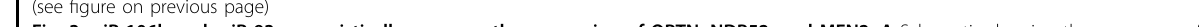
Fig. 3 miR-106b and miR-93 synergistically suppress the expression of OPTN, NDP52, and MFN2. A Schematic showing the sequences of human miR-106b and miR-93, which were predicted to target the 3 ’ UTRs of OPTN, NDP52, and MFN2. B Schematics representing the reconstructed dual-luciferase reporter plasmids. The WT 3 ’ UTRs of OPTN, NDP52, and MFN2 containing the miRNA-binding sequences were cloned downstream of Renilla luciferase ( hRluc ). Arti fi cially mutated miRNA-binding sequences (OPTN-Mut, MFN2-Mut, and NDP52-Mut) were also cloned downstream of Renilla luciferase. Mutations are marked in red. C Cells were transfected with reporter plasmids containing the WT 3 ’ UTR of OPTN or a mutant OPTN 3 ’ UTR (OPTN-Mut) along with a miR-106b mimic or miR-93 mimic for 48 h. Fire fl y luciferase ( hluc + ) and Renilla luciferase ( hRluc ) activity levels were measured successively, and the values are presented as the relative fl uorescence intensity ( hRluc/hluc + ). N = 3; ** P < 0.01. The quanti fi ed results are presented as the mean ± SD. D Cells were transfected with reporter plasmids containing the WT 3 ’ UTR of MFN2 or a mutant MFN2 3 ’ UTR (MFN2-Mut) along with a miR-106b mimic or miR-93 mimic for 48 h. The Renilla luciferase activity was normalized to the fi re fl y luciferase activity. N = 3; ***P < 0.005; **** P < 0.001. The quanti fi ed results are presented as the mean ± SD. E Cells were transfected with reporter plasmids containing the WT 3 ’ UTR of NDP52 or a mutant NDP52 3 ’ UTR (NDP52-Mut) along with a miR-106b mimic or miR-93 mimic for 48 h. The normalized luciferase activity (ratio of hRluc to hluc + ) was measured in cell lysates. N = 3; *** P < 0.005. The quanti fi ed results are presented as the mean ± SD. F , G , I The levels of OPTN, NDP52, and MFN2 in WT cells, three miR-106b-KO cell lines, three miR-93-KO cell lines, and three miR-25-KO cell lines were evaluated by WB analysis. N = 3; ns, not signi fi cant; * P < 0.05; ** P < 0.01; *** P < 0.001. The data are from three independent tests and are presented as the mean ± SD. H WB analysis of OPTN, NDP52, and MFN2 levels 48 h after transfection with a miRNA mimic NC, a miR-106b mimic, or a miR-93 mimic. Tubulin was used as an endogenous control. N = 3; ** P < 0.01; *** P < 0.001; **** P < 0.0001. The data are from three independent tests and are presented as the mean ± SD. J Three cell lines (ShCtrl, shRNF2-1, and shRNF2-2) were transfected with EGFP-C1 or EGFP-Parkin and stimulated with 100 μΜ H 2 O 2 for 0 h or 12 h. The cell lysates were subjected to WB analysis using the indicated antibodies. N = 3; ns, not signi fi cant; * P < 0.05; ** P < 0.01. The data are from three independent tests and are presented as the mean ±